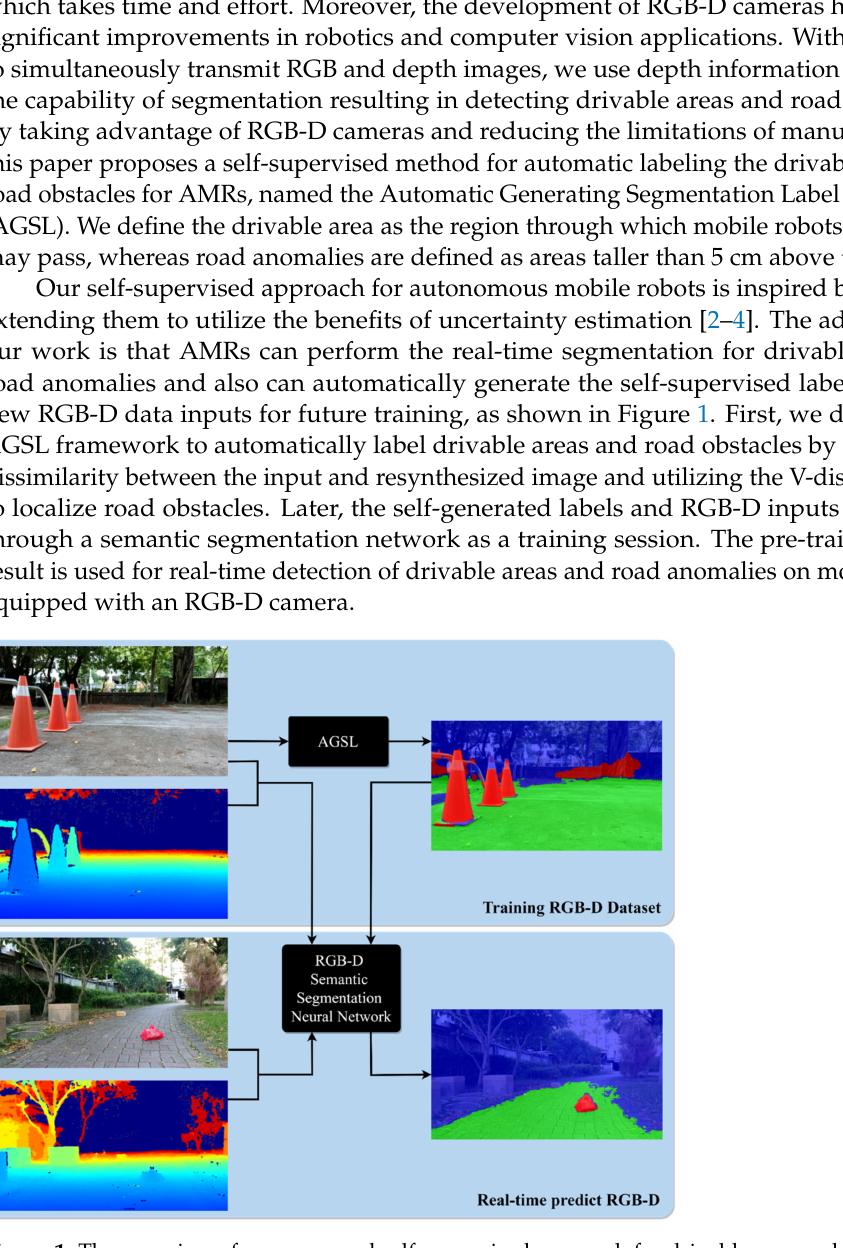
Figure 1. The overview of our proposed self-supervised approach for drivable area and road anoma- lies segmentation. We first apply AGSL framework to generate self-supervised labels (top part), then the AGSL labels are used to train the RGB-D semantic segmentation neural network. At the end, a mobile robot equipped with an RGB-D camera can perform real-time segmentation of drivable areas and road anomalies. The blue area denotes the unknown area, the green area denotes the drivable area, and the red area denotes road anomalies. The figure is best viewed in